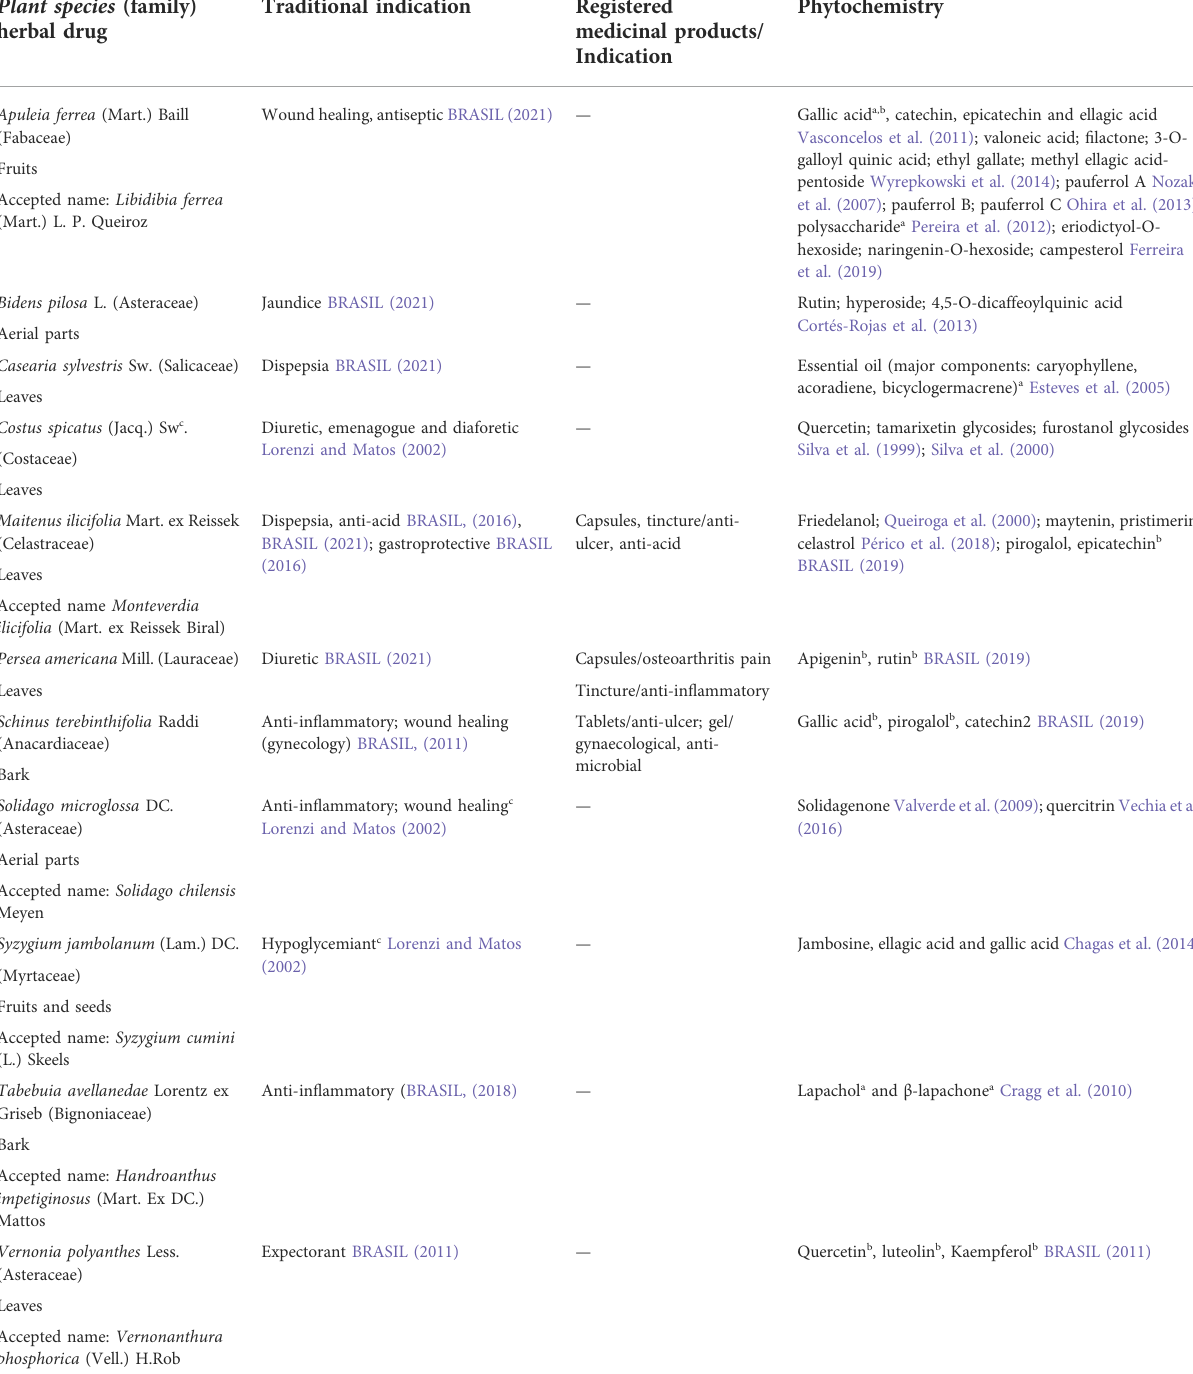
TABLE 1 Summary of the traditional indications and chemical composition of the selected Latin American herbal medicines. Plant species (family) herbal